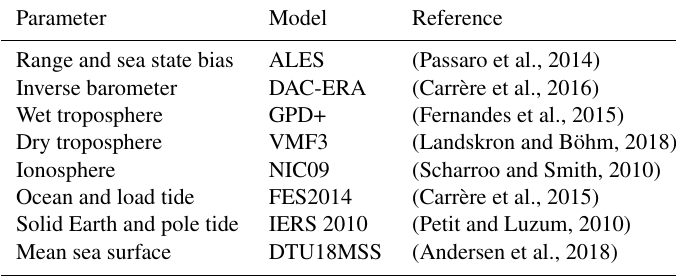
Table 1. Applied models and geophysical corrections for estimating sea level